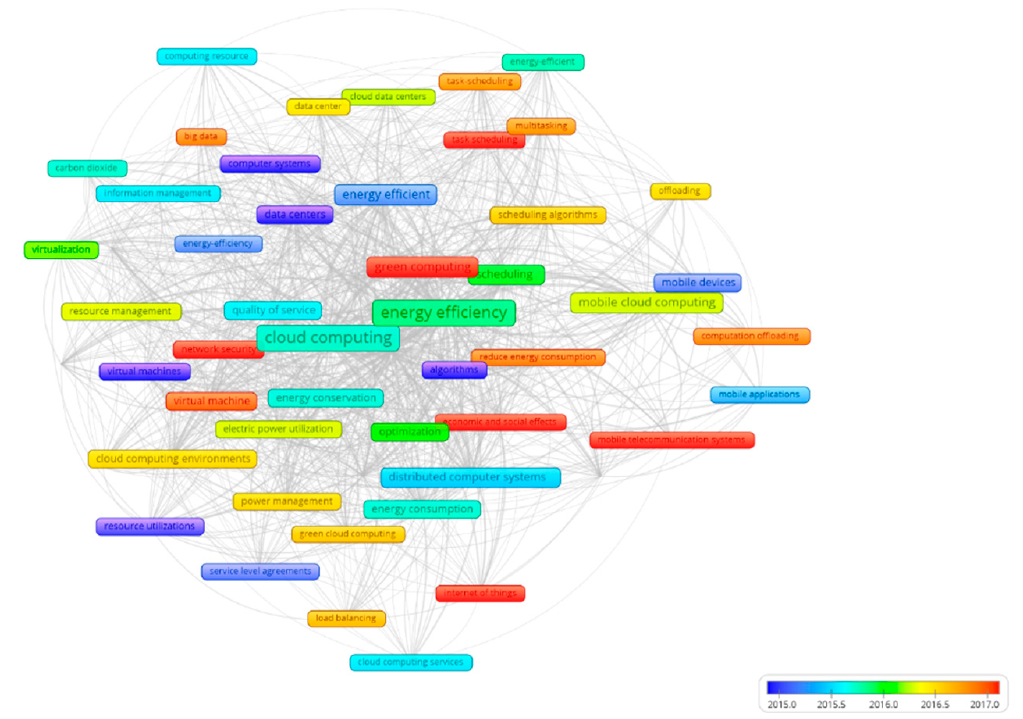
Figure 5. Average date of publication of high-frequency keywords in research on cloud computing energy efficiency. Source: authors’ own study. Data sourced from Scopus, analyzed with VOSviewer